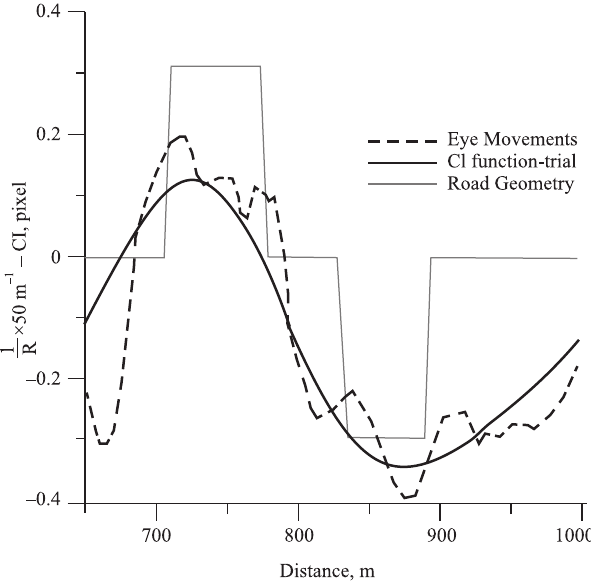
Fig. 3. Relationship among CI function, Head - Eye Movements and Road